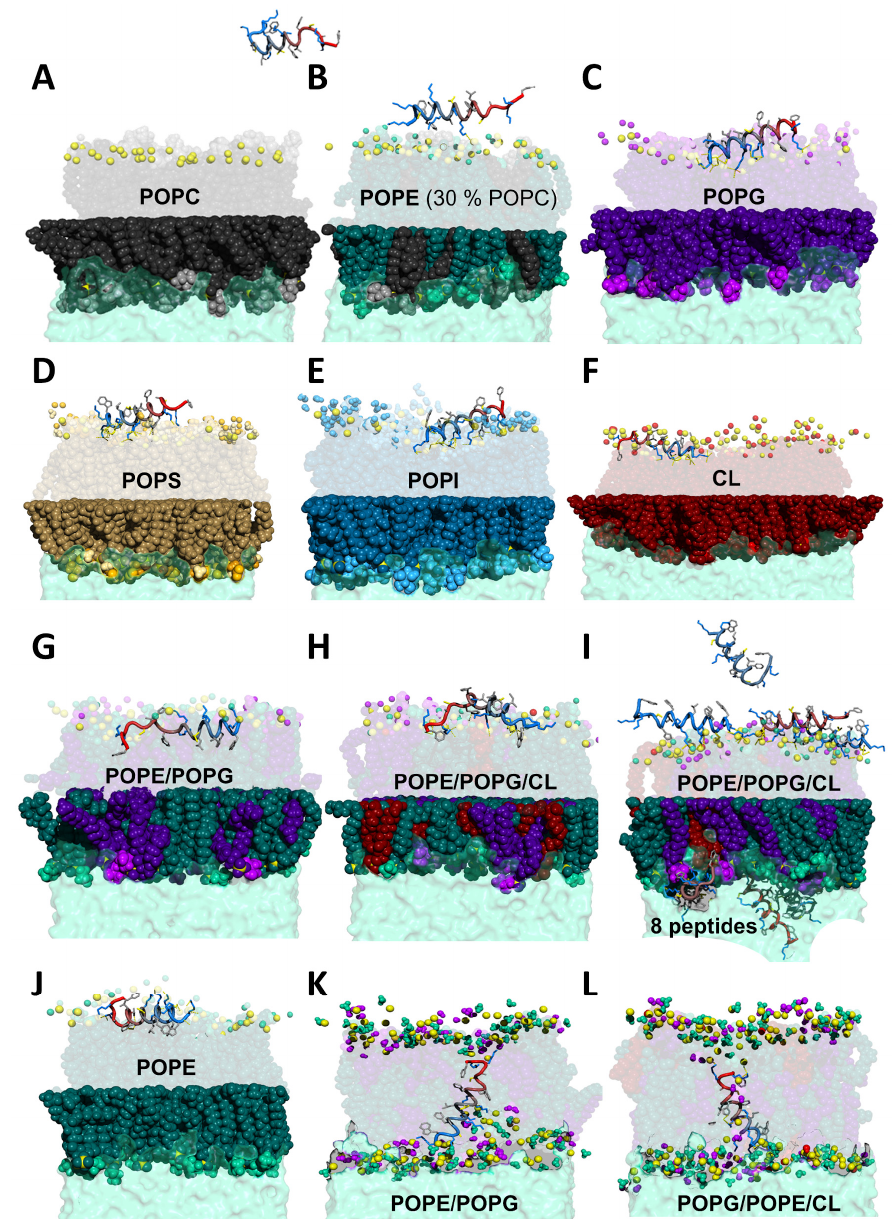
Figure 4. MD snapshots representative of K11 peptide interacting with several membranes of variable phospholipid compositions. Color code: ( A ) POPC black (body) and light gray (choline group); ( B ) POPE dark green (body), turquoise (headgroup) and light green (amine of the headgroup); ( C ) POPG dark violet (body), violet (headgroup) and light violet (hydroxyls of the headgroup); ( D ) POPS brown (body), gold (headgroup), light yellow (amine of the headgroup) and orange (carboxyl of the headgroup); ( E ) POPI blue (body), light blue (headgroup) and cyan (hydroxyls of the headgroup); ( F ) CL dark red (body) and light red (headgroup). Panels G-H show lipid mixtures typically found in bacteria: ( G ) POPE/POPG and ( H ) POPE/POPG/CL. Panel ( I ) represents an example of calculation with eight peptides while panel ( J ) refer to a calculation of one peptide interacting with a pure POPE membrane, differing from that in panel B for the absence of POPC. Snapshots in panels ( K ), ( L ) refer to examples of simulations where K11 is purposely placed inside the membrane at the start of the calculation. In all panels the phosphorus atom of phospholipids is shown as a yellow sphere; for clarity, only functional moieties of headgroups are represented as spheres either in the upper leaflet, or in both leaflets (panels K, L). K11 peptide is shown as a “tube” colored from blue (N-terminus) to red (C-terminus) except in panel I where each of the eight peptide has a different color. Side chains are shown as sticks with the following color code: positively charged (blue), negatively charged (red), non-polar (light gray), polar